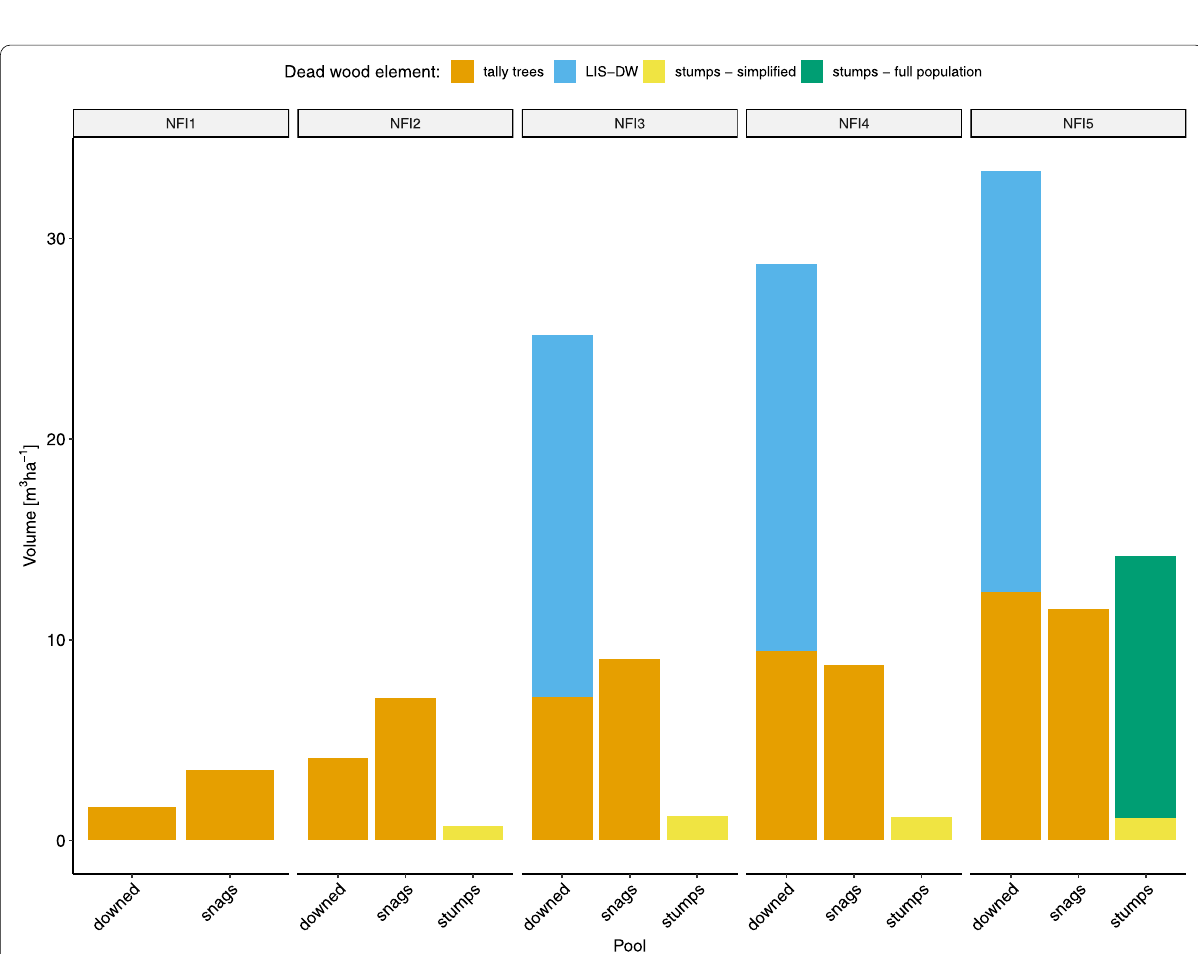
Fig. 5 Mean volume in the dead wood pools standing, downed, and stumps in the NFI1, NFI2, NFI3, NFI4, and NFI5 shown for comparable dead wood elements across NFIs: standing and downed tally trees 12 cm DBH, LIS-DW (all downed dead wood sampled with the “line-intersect” ≥ method), stumps — simplified (stumps for the population of “new stumps” as identified since the NFI2 and volume based on the DBH of the tally tree from the previous inventory and 30 cm height, cf. Fig. 2), stumps — full population (stumps for the full population of the NFI5 and volume-based upslope and downslope stump height and diameters at top and half the downslope height, cf. Fig. 3b). Note that (i) simplified stump volume could only be estimated since the NFI2 since the DBH of the tally tree from the previous inventory was required, (ii) LIS-DW data were not collected in NFI1 and NFI2, and (iii) the standing and downed tally tree data are based on the stemwood only, corresponding to full volume in NFI1 and NFI2 and reduced volume for damaged tally trees since NFI3. The data are based on common sample plots as in Fig.